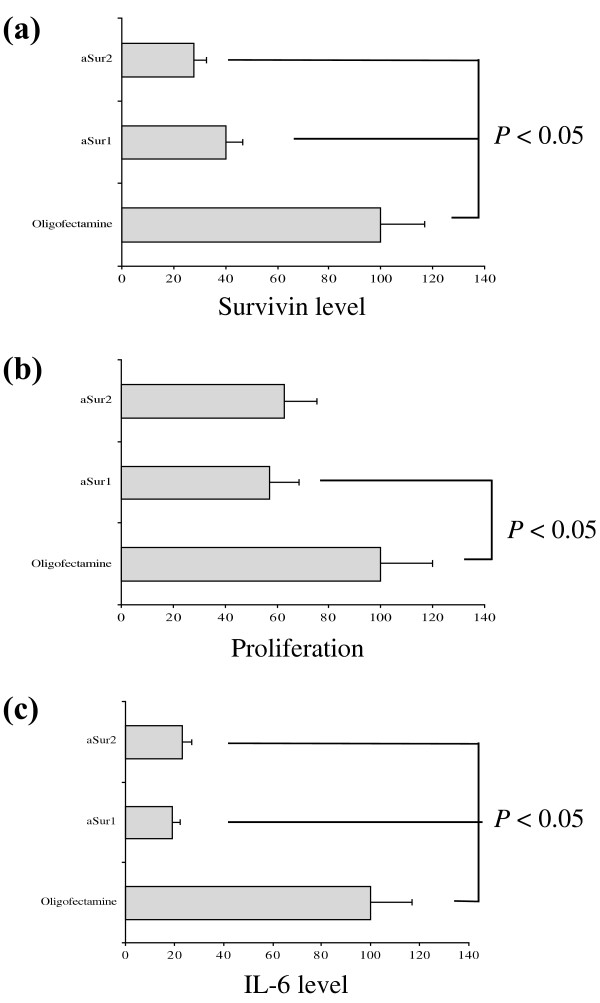
Modulation of (a) survivin expression, (b) proliferation, and (c) IL-6 production following transfection of THP-1 cells with anti-sense oligonucleotides specific for survivin mRNA and non-sense sequences. Data are provided as the percentage of phytohaemagglutinine-stimulated THP-1 cells. The concentration of oligonucleotides throughout was 300 nM.